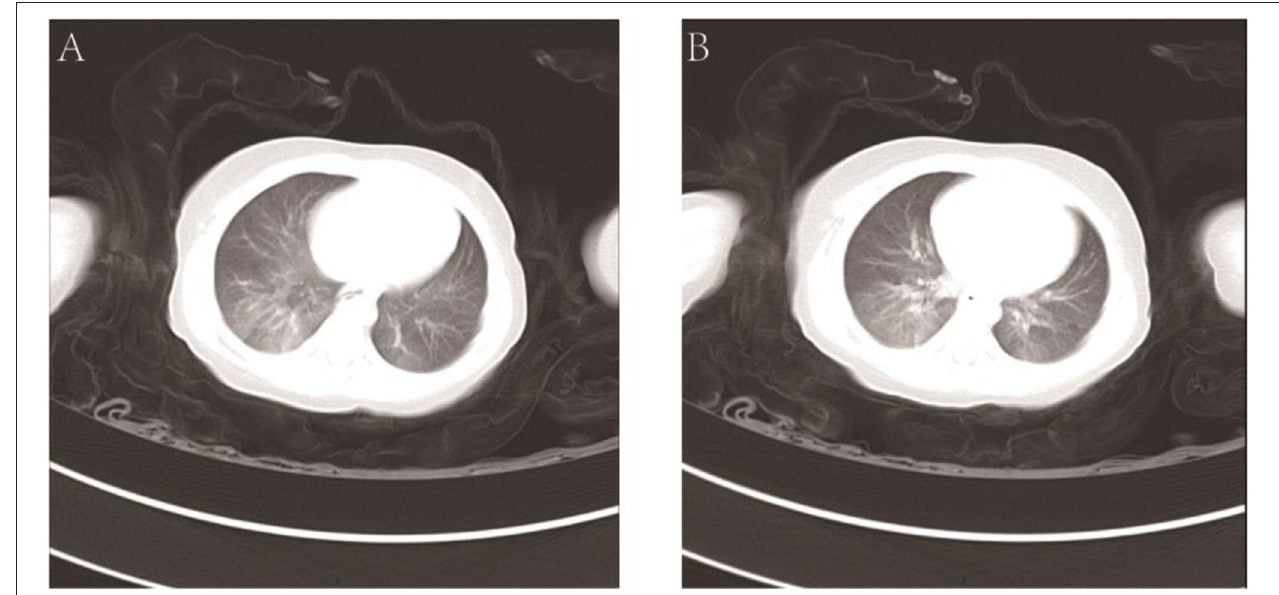
FIGURE 2 | CT coronal scan of the lung (A,B)